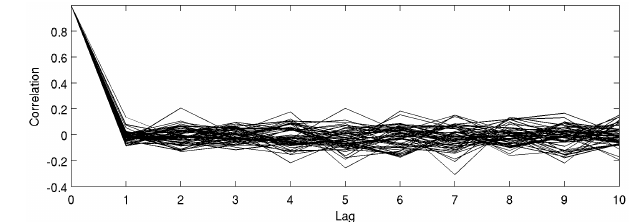
Figure 3. The autocorrelation vs. lag for the stochastic forcing as- sociated with each principle component element of p in Eq. (14).